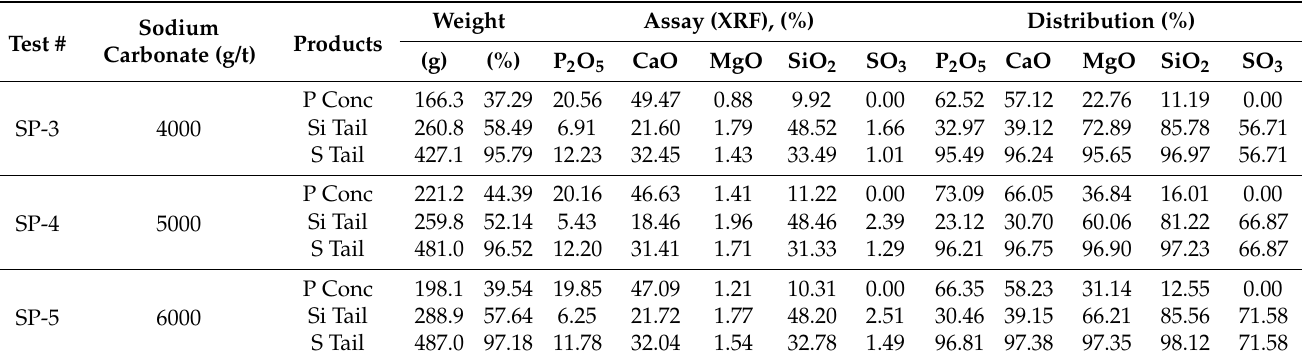
Table 3. The results of phosphate rougher flotation.